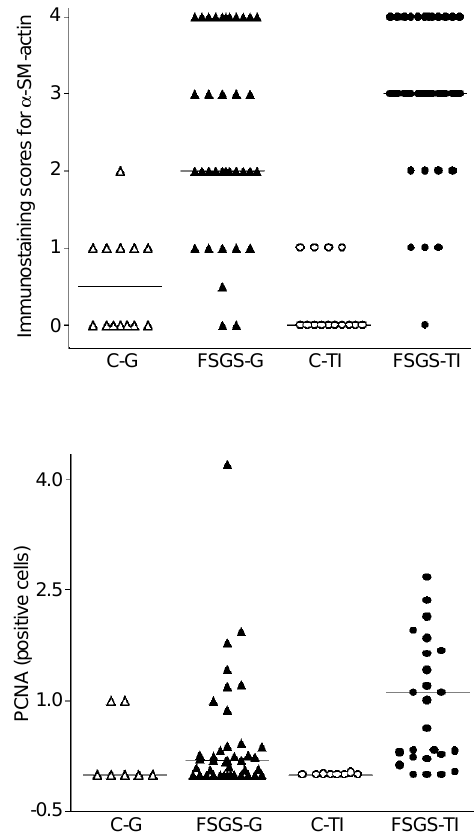
Figure 1. Expression of a - smooth muscle actin ( a -SM-ac- tin) in glomeruli (G) or in the tu- bulointerstitial area (TI) from the renal cortex of patients with fo- cal segmental glomerulosclero- sis (FSGS, N = 41) and of control individuals (C, N = 14). The me- dian is shown as a horizontal line.